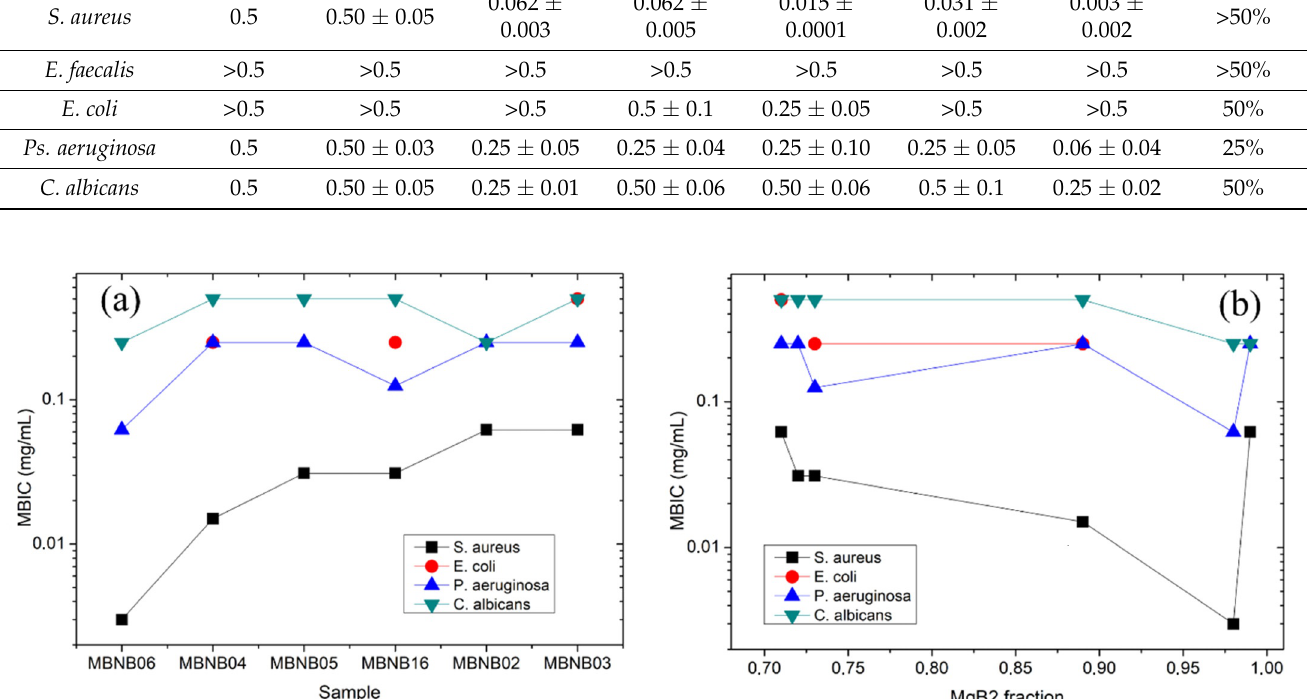
Figure 7. MBIC values plotted as ( a ) a function of the overall sample antimicrobial activity (decreasing from left to right) and ( b ) as a function of the MgB 2 phase content listed in Table 1.